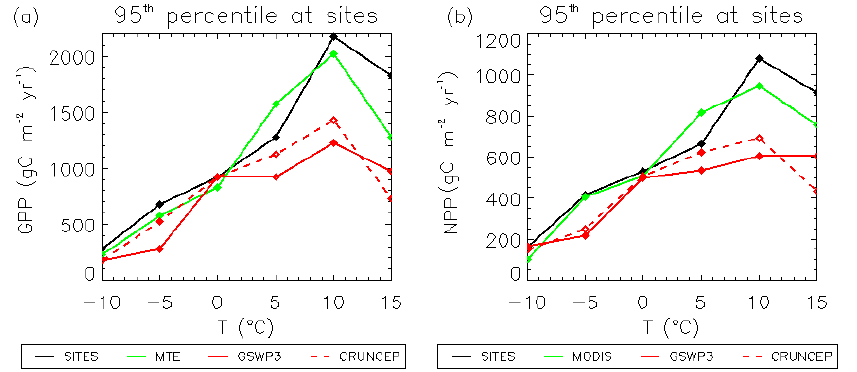
Figure 16. 95th percentiles of mean annual (a) GPP (gCm − 2 yr − 1 ) and (b) NPP (gCm − 2 yr − 1 ) distributions per temperature bins of 5 ◦ C for in situ measurements, the gridded MTE-GPP (MODIS-NPP) product sampled at the sites’ locations and the two simulation results, averaged over the period 2000–2007.